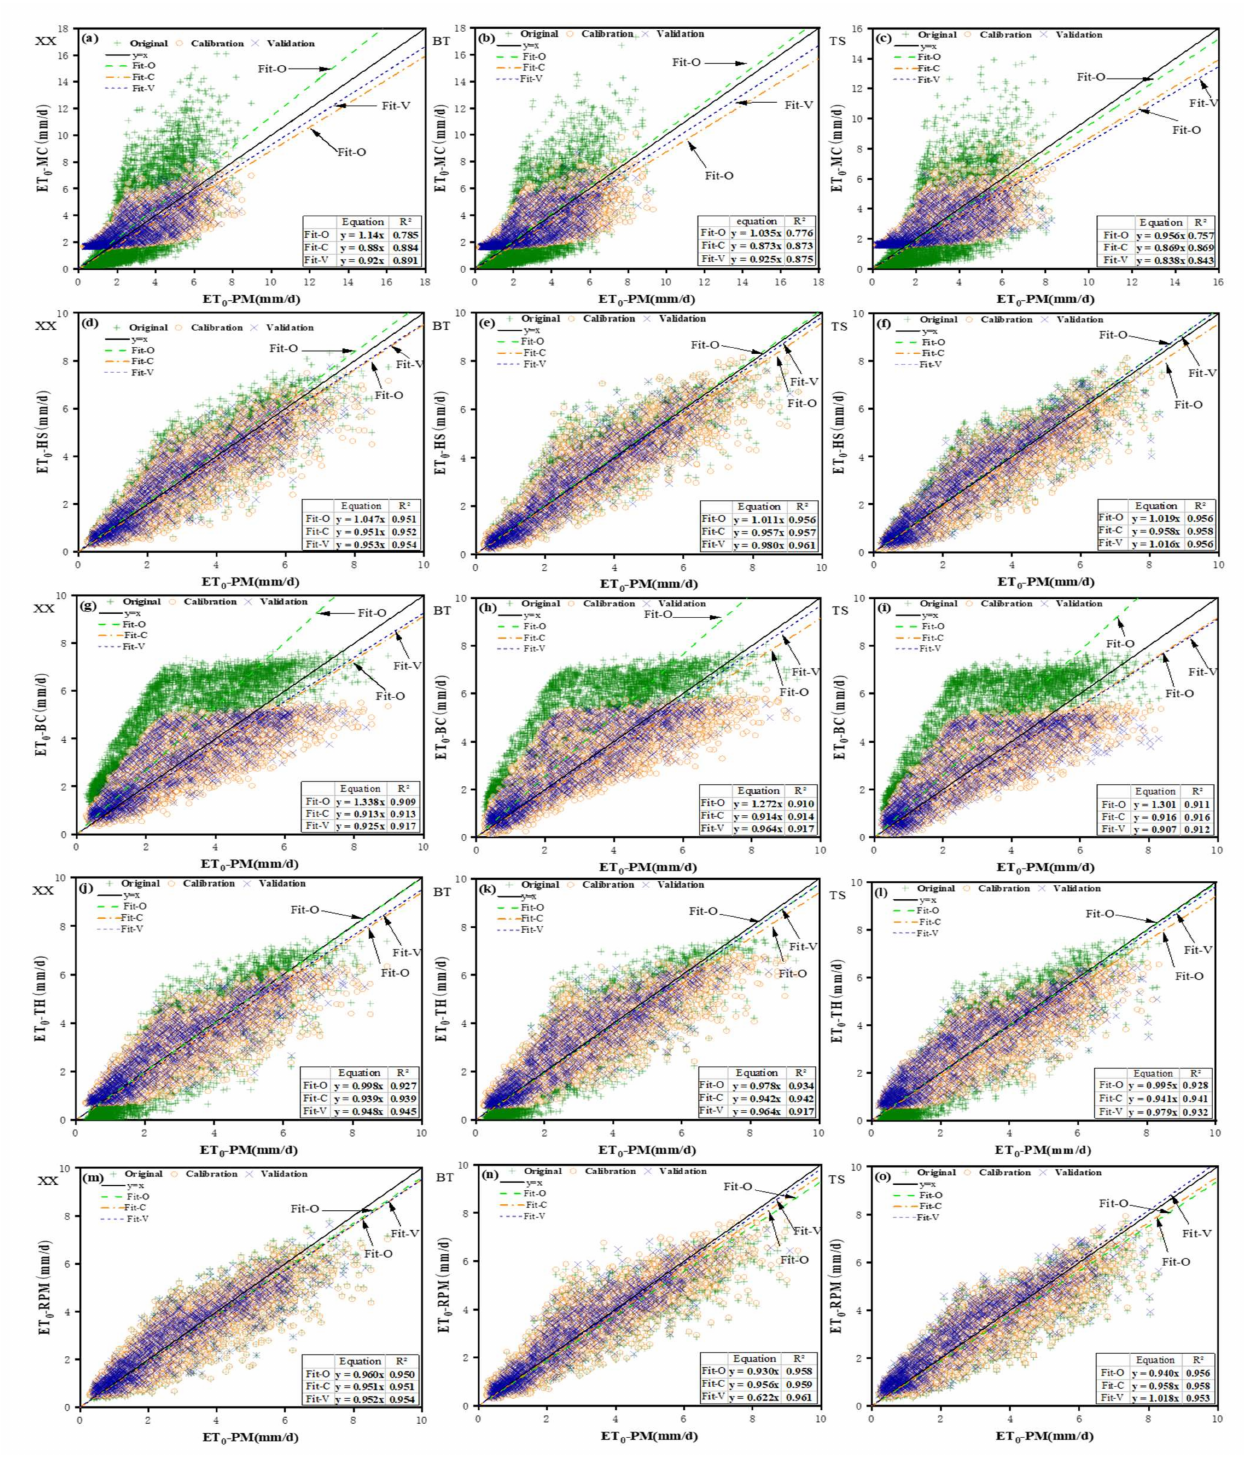
Figure 4. Scatterplots for ET 0 calculated by the temperature-based models and the PM model for original, calibrated, and validated models in stations BT, TS, and XX; ( a – c ) MC model, ( d – f ) HS model, ( g – i ) BC model, ( j – l ) TH model, ( m – o ) RPM model; Fit-O, Fit-C, and Fit-V are respectively the best fit lines for the original, calibrated, and validated